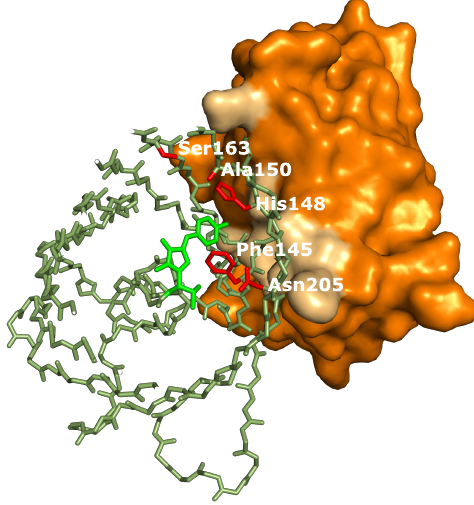
Figure 6. rsGreen0.7 (Protein Data Bank (PDB) accession code: 4xow) aligned to replace green fluorescent protein (GFP) in the structure of Enhancer:GFP (PDB accession code: 3k1k). Colors used: Enhancer (orange, interacting surface in light-brown), rsGreen0.7 (dark-green, chromophore in light-green, residues important for photoswitching in red). In the structure of rsGreen1 and rsGreenF all residues shown are identical to rsGreen0.7, except for the following mutations: L44M, K101E, F145L only in rsGreenF, N149D only in rsGreen1, K162R and